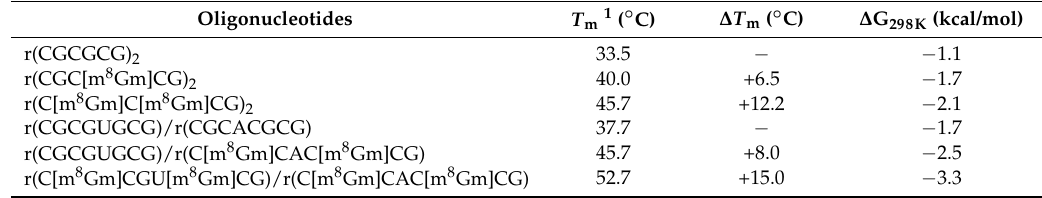
Table 2. Thermodynamic parameters for A-Z transition of various m 8 Gm-containing RNAs. Oligonucleotides